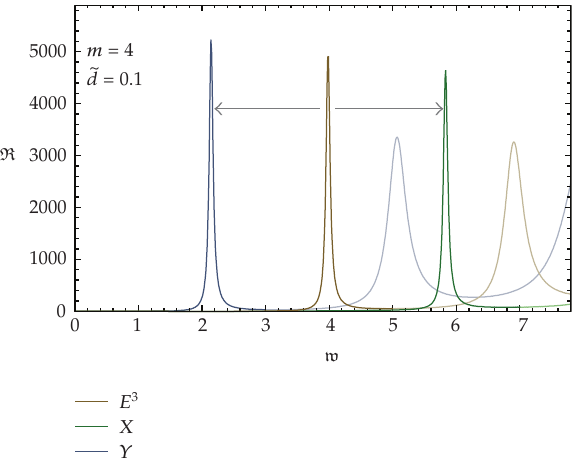
Figure 15: The vector meson spectral functions of the three isospin components. For a concise image we emphasize the first peak of each component by stronger color